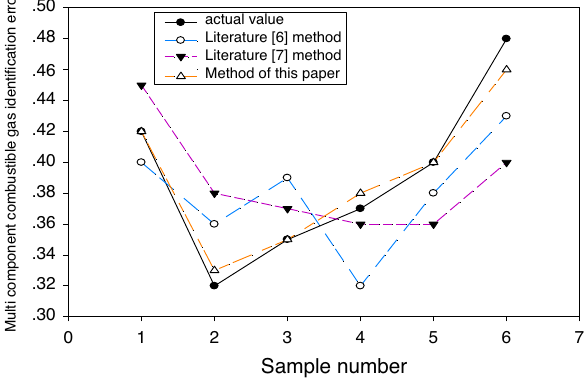
Figure 12: Identi fi cation error of explosion